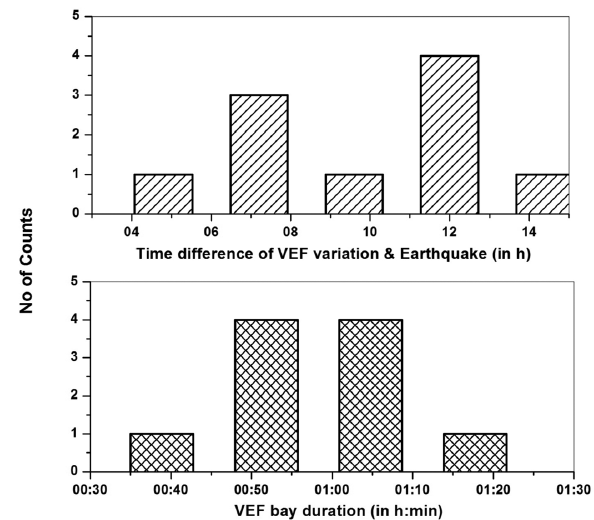
Figure 9. Histograms showing time difference of VEF variation (top) and earthquake and VEF bay duration